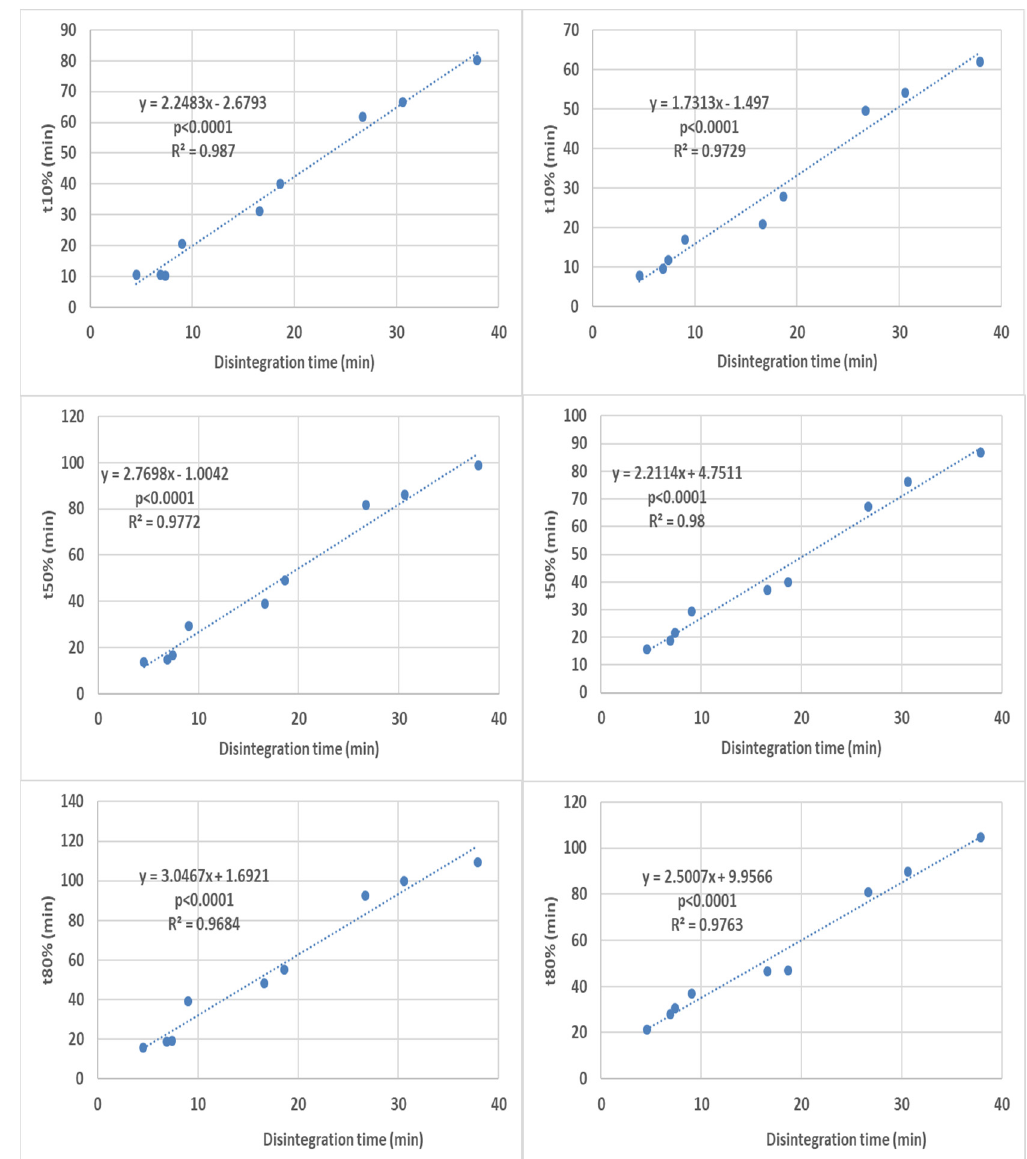
Figure 4. Overall correlation of all the disintegration results with their respective dissolution results (all formulations in all media are present in each graph) in the basket apparatus (right-hand side) and the paddle apparatus (left-hand-side) . The p -value is a one-sided value for a t -test applied to the slope.